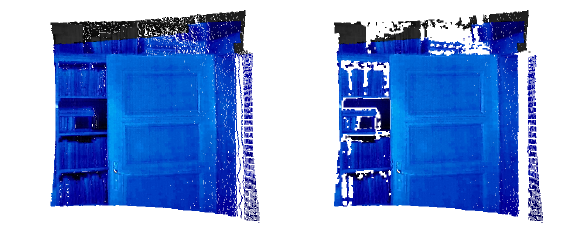
Figure 9: Automatically selected point correspondences between the masked images.